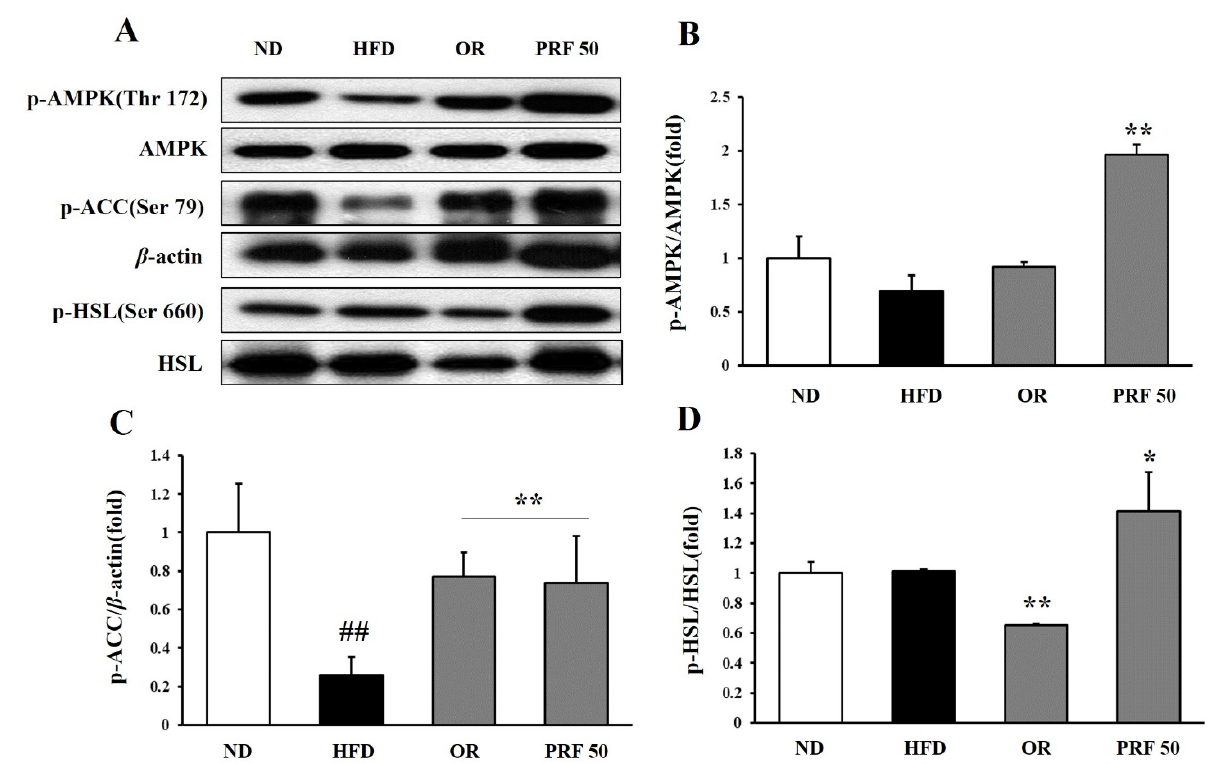
Figure 5. Effect of PRF on the regulation of lipid-metabolism-related protein expression in epididymal adipose tissue in HFD-induced obese mice. The expression of p-AMPK, AMPK, p-ACC, p-HSL, HSL, and β -actin was analyzed by Western blot analysis ( A ), and the intensity of each band was measured using ImageJ. The relative intensity of p-AMPK/AMPK ( B ), p-ACC/ β -actin ( C ), and p-HSL/HSL ( D ). The results are expressed as the means ± SDs ( n = 3; ## p < 0.01 compared to ND; * p < 0.05, ** p < 0.01 compared to HFD). ND, normal diet; HFD, high-fat diet; OR, HFD + 15.6 mg of orlistat; PRF 50, PRF 100, and PRF 200, HFD + 50, 100, and 200 mg of PRF, respectively.